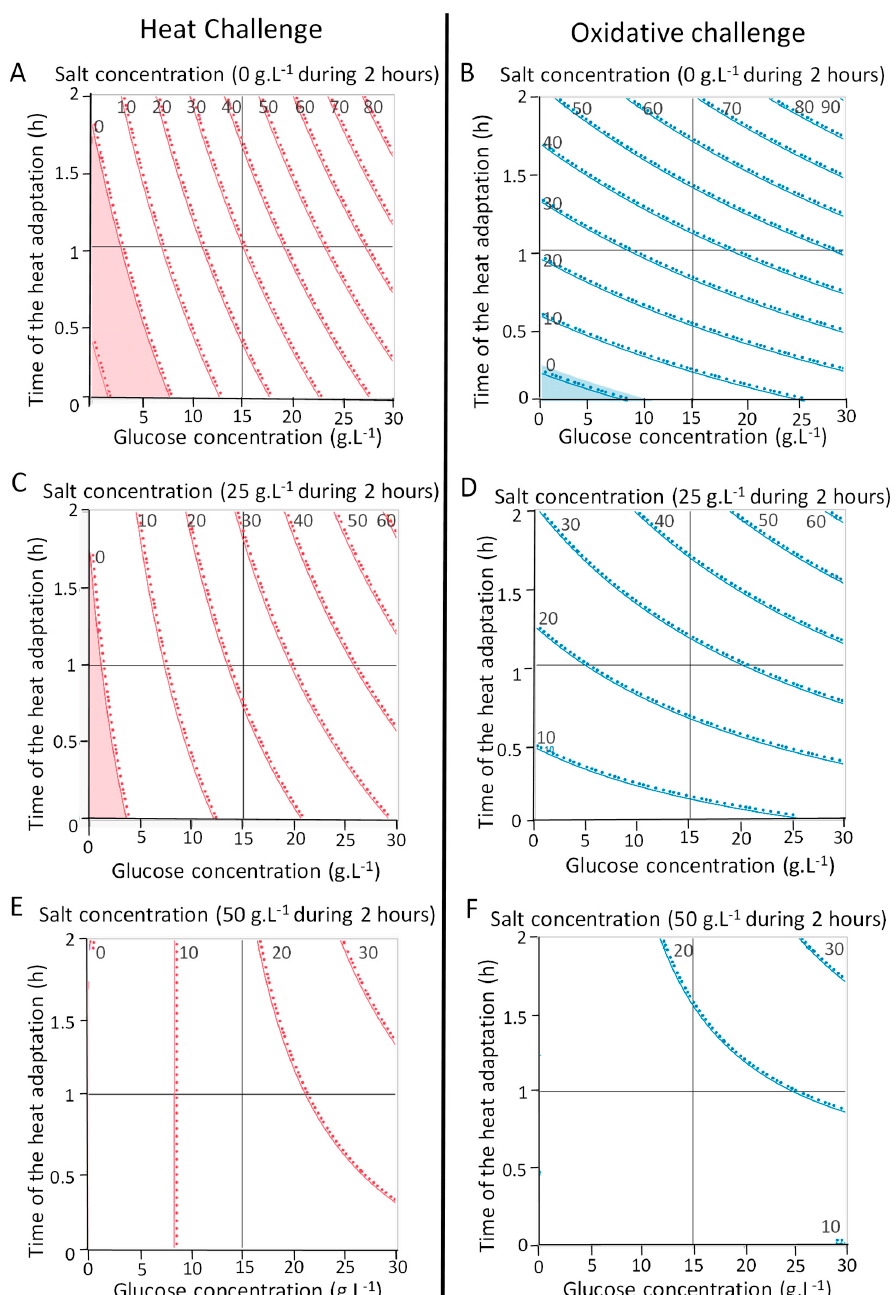
Figure 1. Adaptations and growth medium compositions modulate P. freudenreichii stress tolerance. E ff ect of addition of glucose, heat-adaptation and osmoadaptation were tested on P. freudenreichii CIRM-BIA 129 stress tolerance following an experimental design. P. freudenreichii was cultivated in YEL medium with 0.15 or 30 g · L − 1 of glucose until the beginning of the stationary phase. Cultures were then subjected to osmoadaptation (0.25 or 50 g · L − 1 of NaCl) over 2 h and then heat-adapted at 42 ◦ C over 0, 1 or 2 h. Cultures were subjected to heat challenge ( A , C , E , 60 ◦ C for 10 min) or oxidative challenge ( B , D , F , 1.15 mM H 2 O 2 for 1 h) as described in materials and methods. P. freudenreichii viability after challenges was determined by CFU counting before and after challenges. Results are expressed as percent survival and reported near the iso-response curves.